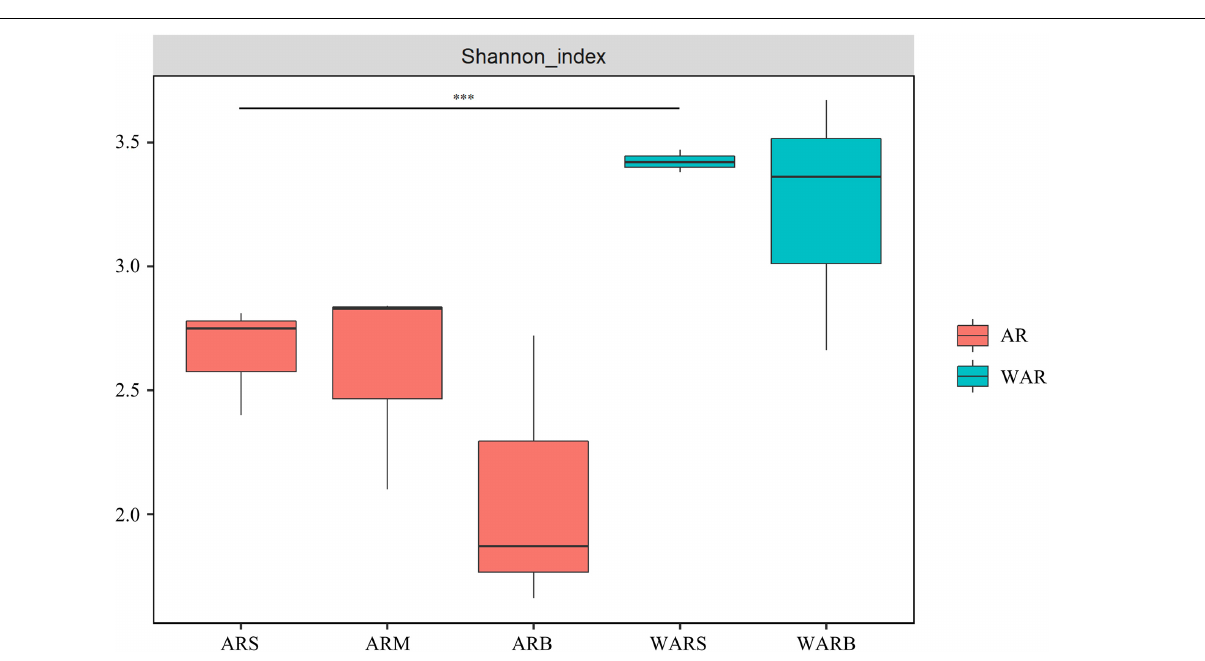
FIGURE 3 | Shannon diversity index. Shannon diversity index of the upper, middle and bottom layers of the ARs (ARS, ARM, and ARB). Shannon diversity index of the surface WAR and bottom WAR (WARS and WARB, respectively). Comparing the samples at both ends of the line, ∗∗∗ indicates an extremely significant